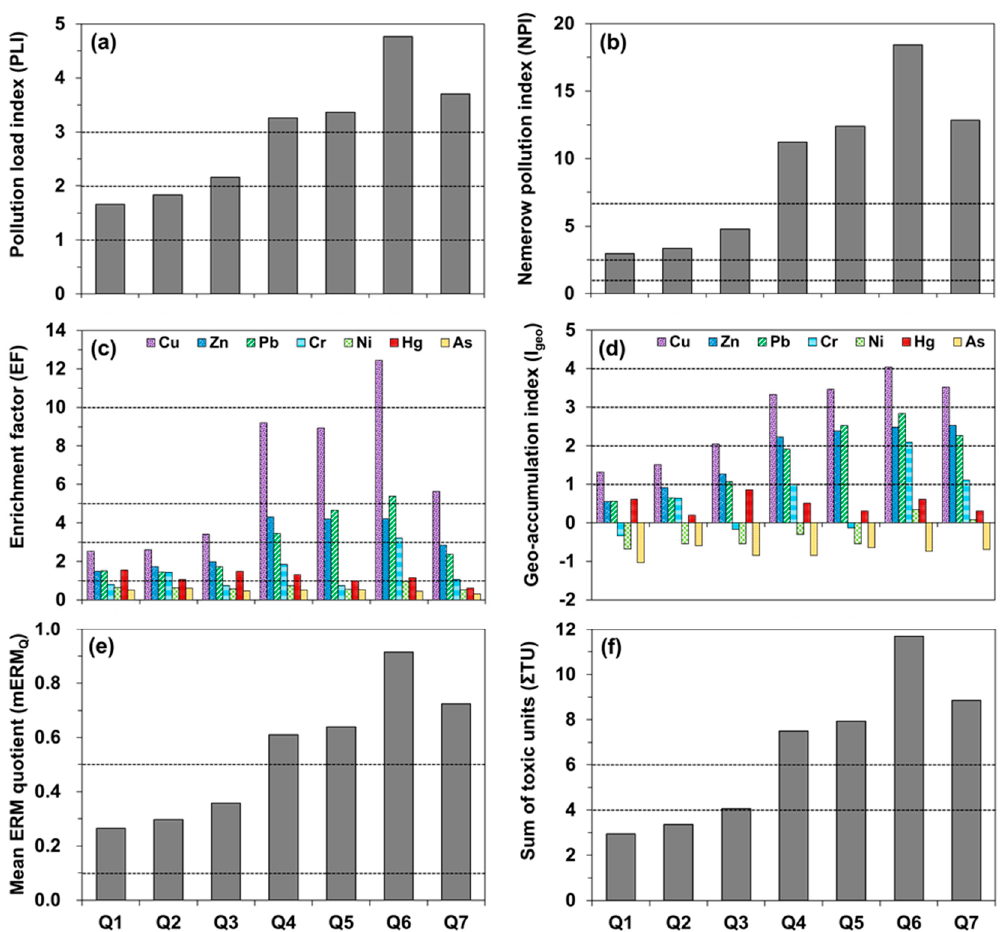
Figure 3. ( a ) Pollution load index ( PLI ), ( b ) Nemerow pollution index ( NPI ), ( c ) enrichment factor ( EF ), ( d ) geo ‐ accumulation index ( I geo ), ( e ) mean ERM quotient ( mERMq ), and ( f ) sum of toxic